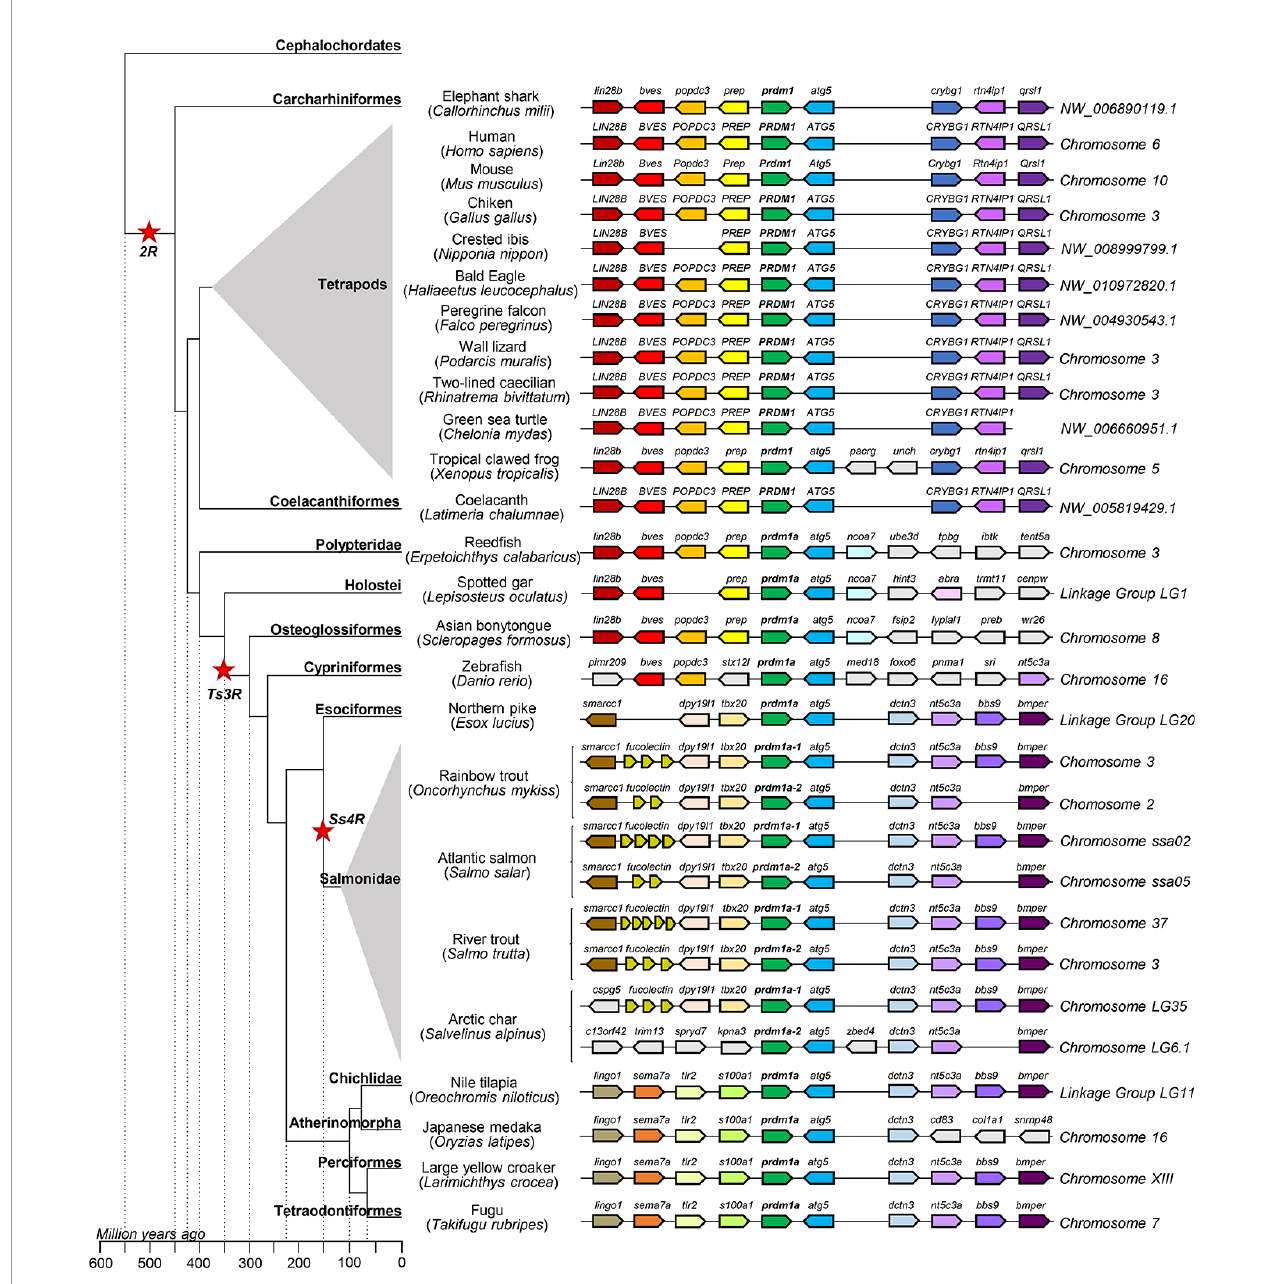
FIGURE 3 | Synteny analysis of the prdm1a group from O. mykiss associated to phylogenetic reconstruction. Different genes are represented by different colored arrows. The prdm1a neighboring genes were identi fi ed along different genomes available in the RefSeq database. Nonconserved genes along the fi gure are shown in gray. Arrows indicate the gene direction relative to prdm1a